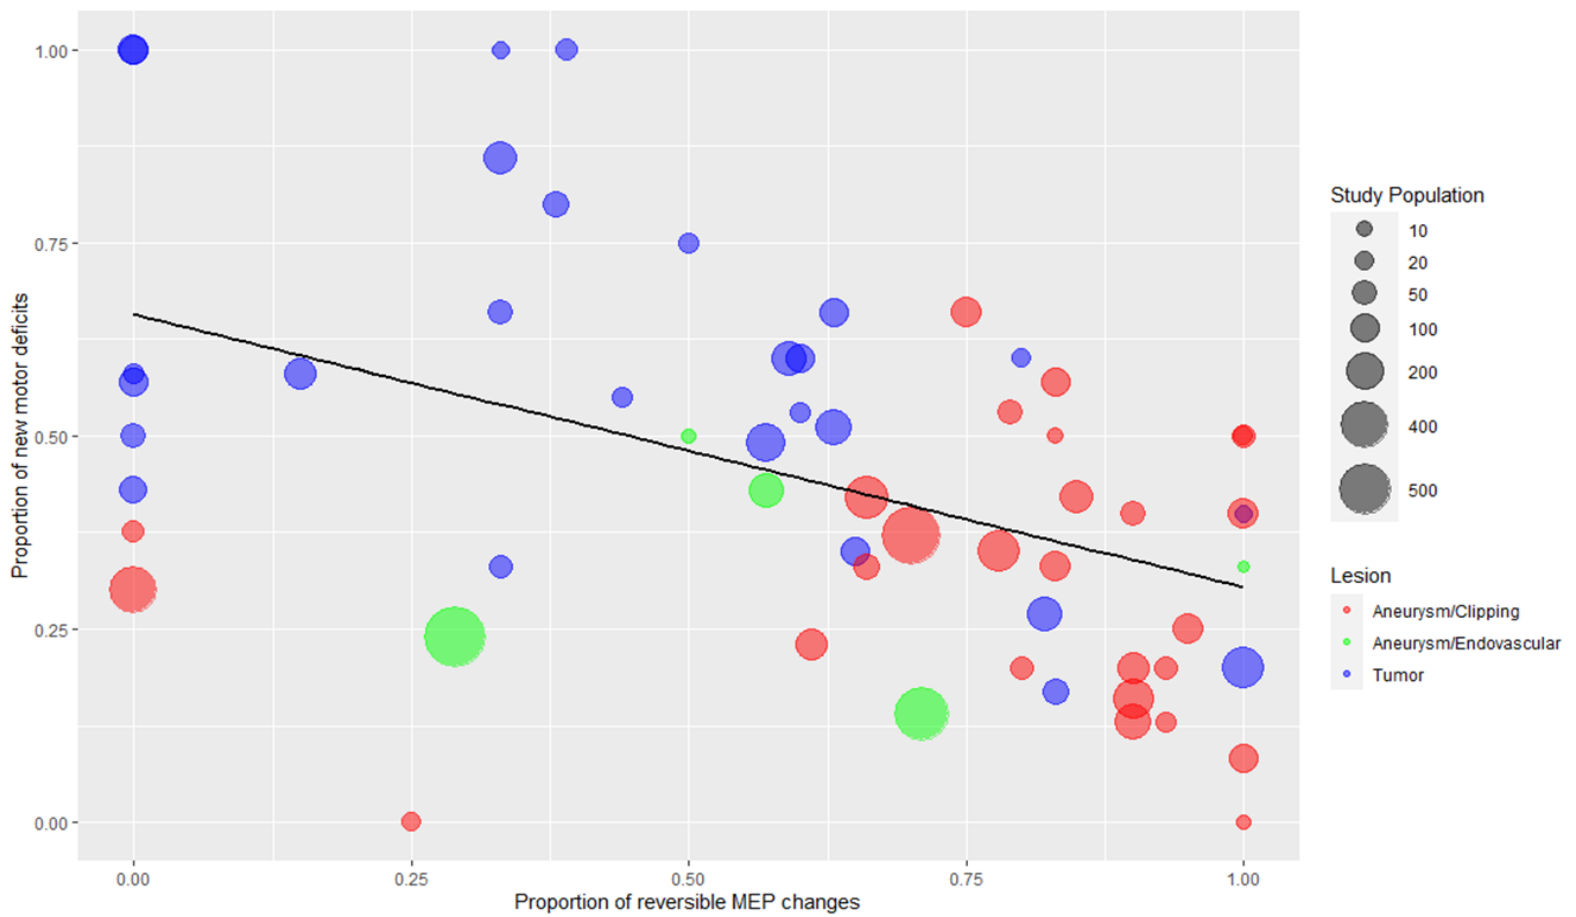
Figure 4. Bubble plot with regression line depicting the negative correlation between the proportion of reversible MEP changes and proportion of new motor deficits associated with MEP changes. Each dot represents one study, and the color corresponds to the type of the lesion (blue: tumor, red: aneurysm/clipping, green: aneurysm/endovascular procedures). The two studies of epilepsy surgery are depicted together with tumors (blue color). The third dimension added is the study population size, which is displayed by the size of each dot. Spearman’s rank correlation coefficient = − 0.498 ( p < 0.001).